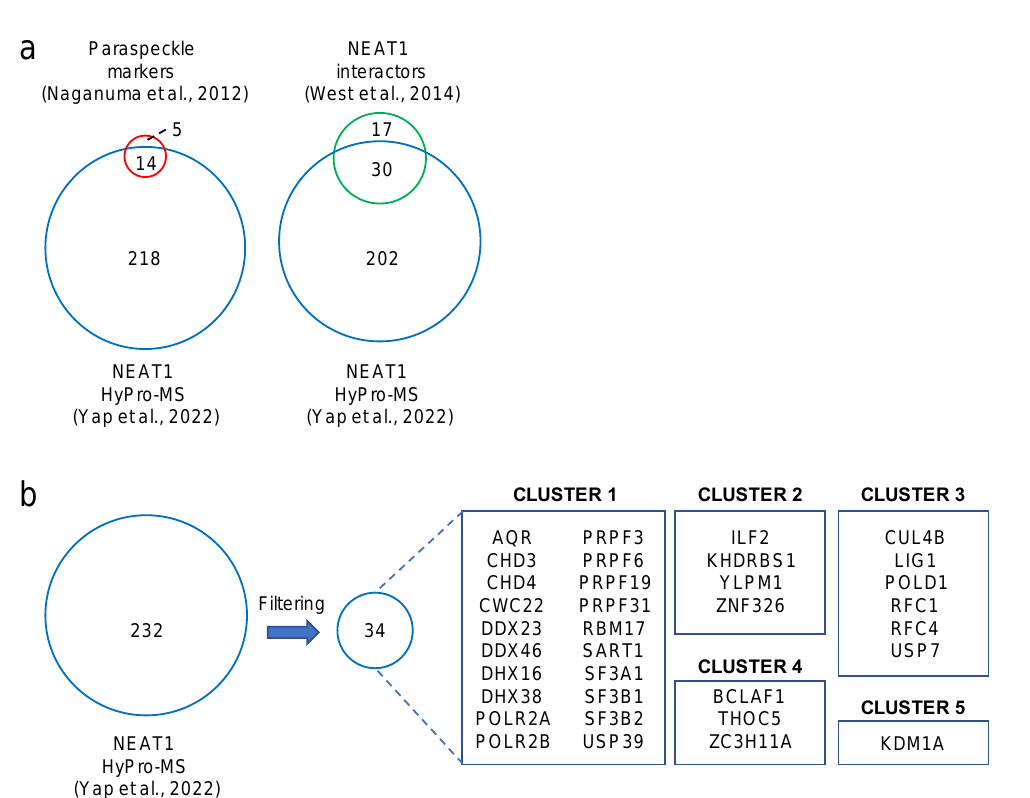
Figure 3. HyPro-mass spectrometry (HyPro-MS) identifies novel NEAT1 interactors. ( a ) Venn diagrams display significant overlap of 232 NEAT1 HyPro-MS candidates (light blue, [17]) with 19 paraspeckle markers previously identified by confocal imaging (light red, [26]) and 47 NEAT1 interactors previously identified by mass spectrometry (light green, [52]). ( b ) Filtering of NEAT1 HyPro-MS candidates for high-confidence protein sets, exclusion of candidates from cell biological imaging [26] and biochemical purification [52], molecular complex detection software, and gene ontology analysis results in 5 clusters of 34 newly identified NEAT1 interaction candidates. The 5 clusters were defined by Yap and colleagues as described, but do contain additional known paraspeckles components, which are not depicted here.